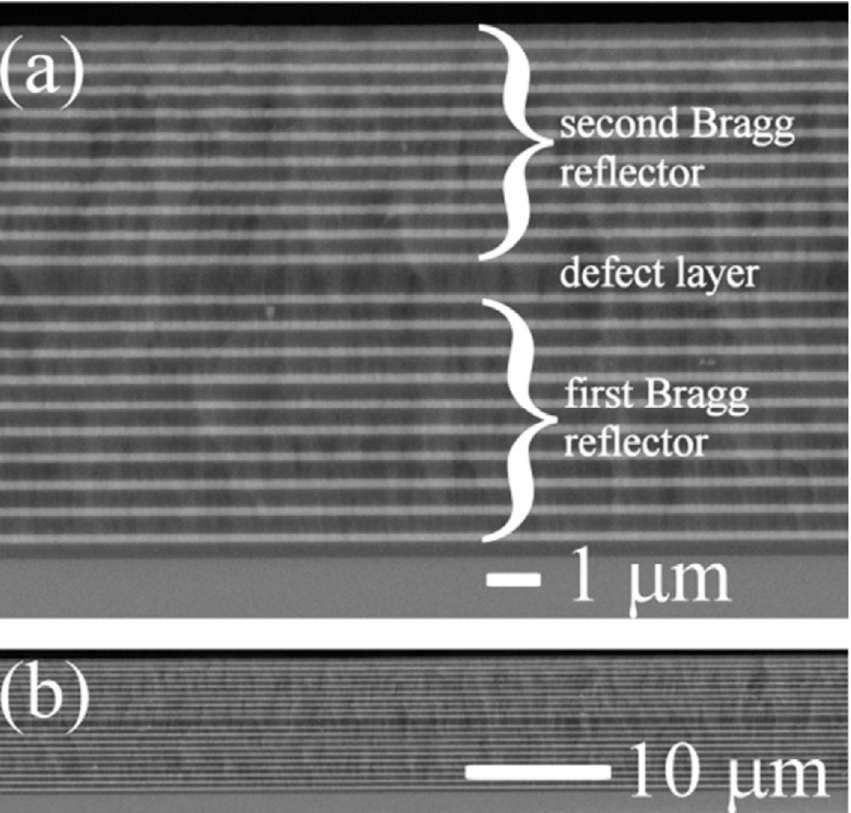
Figure 14. SEM image of the cross section of a 1D microcavity fabricated by Chiasera et al. [99]. The bright and the dark areas correspond to TiO 2 and SiO 2 layers, respectively. The substrate is located at the bottom of the images and the air at the top. ( a ) Image of a section of the sample of about 16 µm in length. ( b ) Image of a section about 60 µm long. Reproduced with permission from [99] Copyright 2015, Elsevier.